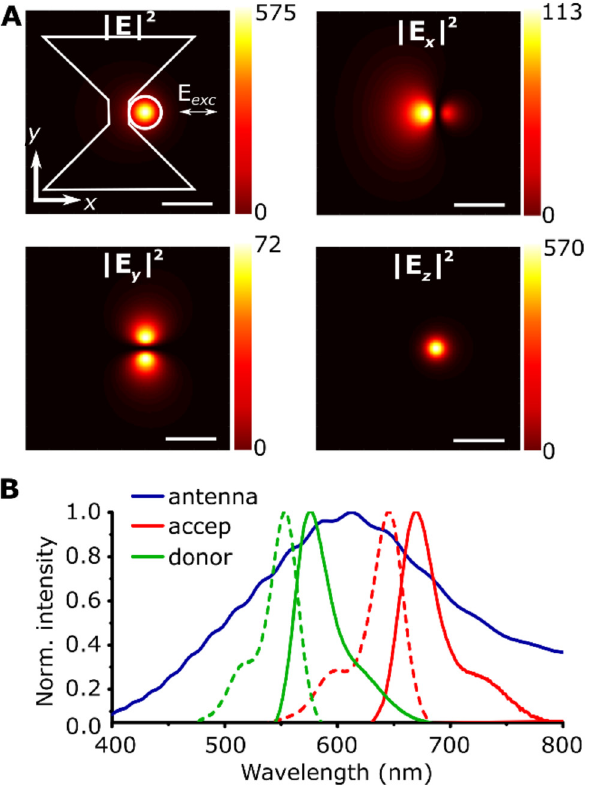
Figure 2: (A) FDTD simulations of the near-field intensity enhance- ment (ratio of intensity in presence and absence of the antenna) provided by a hybrid antenna (30 nm in diameter, 70 nm in length), 10 nm away from the monopole end. Both the total field as well as the x , y , and z components of the near- fi eld are displayed. Scale bars: 100 nm. (B) Absorption (dashed lines) and emission (solid lines) spectra of both the donor (green) and acceptor (red) dyes. The broad resonance spectrum of the hybrid antenna obtained from FDTD simulations is shown in blue.